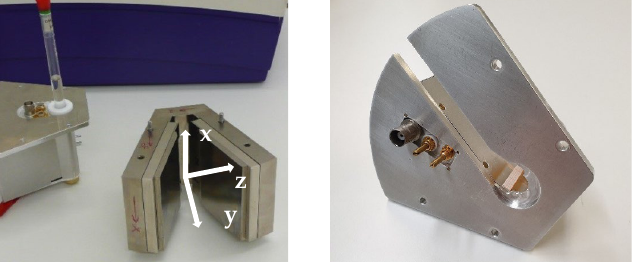
Figure 1. Left : V-shaped NMR sensor (V-magnet with coordinate system and rf probe for off-line measurements) [15] and, on the Right, the inline-capable rf probe. The probe is positioned in the magnets ”V“ so that the sample is aligned along x ( Left : typical 10 mm sample as used in low-field NMR). Since the inline probe ( Right picture) has a slit, it can be easily mounted on tubes without opening the fluidic flow system. The rf connectors and the trim capacitors are also shown (Figure 1 left: Reprinted/adapted with permission from Ref.[15]).